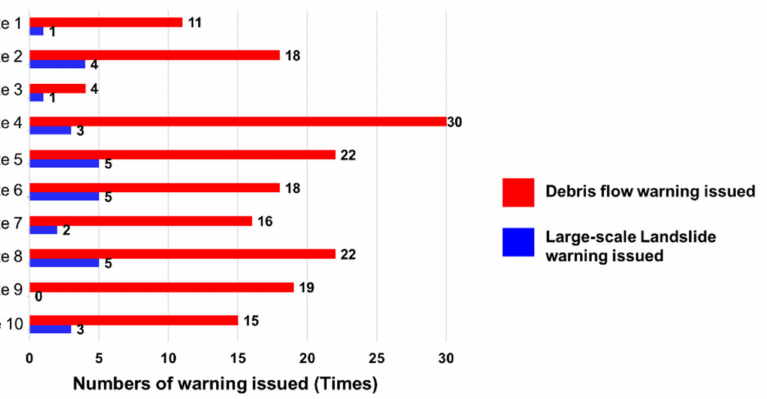
Figure 17. Number of warnings issued for debris flow and large-scale landslides from 2011 to